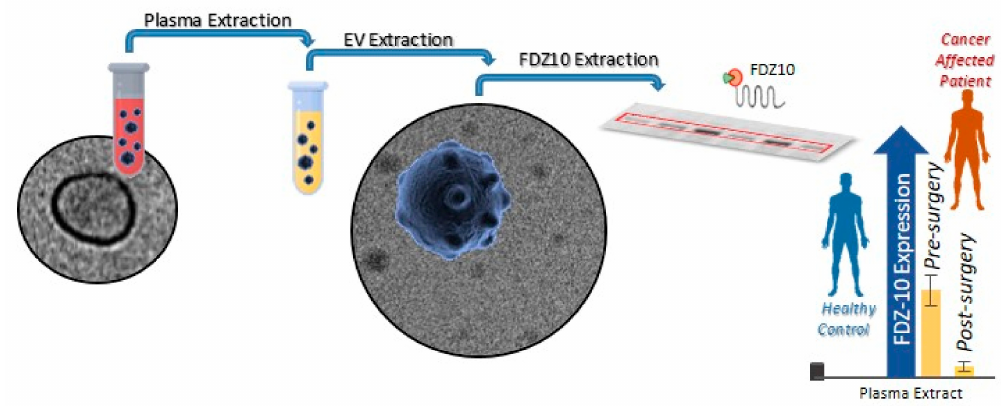
Figure 2. Schematic illustration of the possible use of the FZD10 vehiculated in human plasma extracellular vesicles (EVs) as a prognostic biomarker for the early diagnosis of two specific gastrointestinal cancers (colorectal cancer (CRC) and gastric cancer (GC)) and for monitoring the treatment response by an evaluation of the protein expression level in healthy control subjects vs. oncological